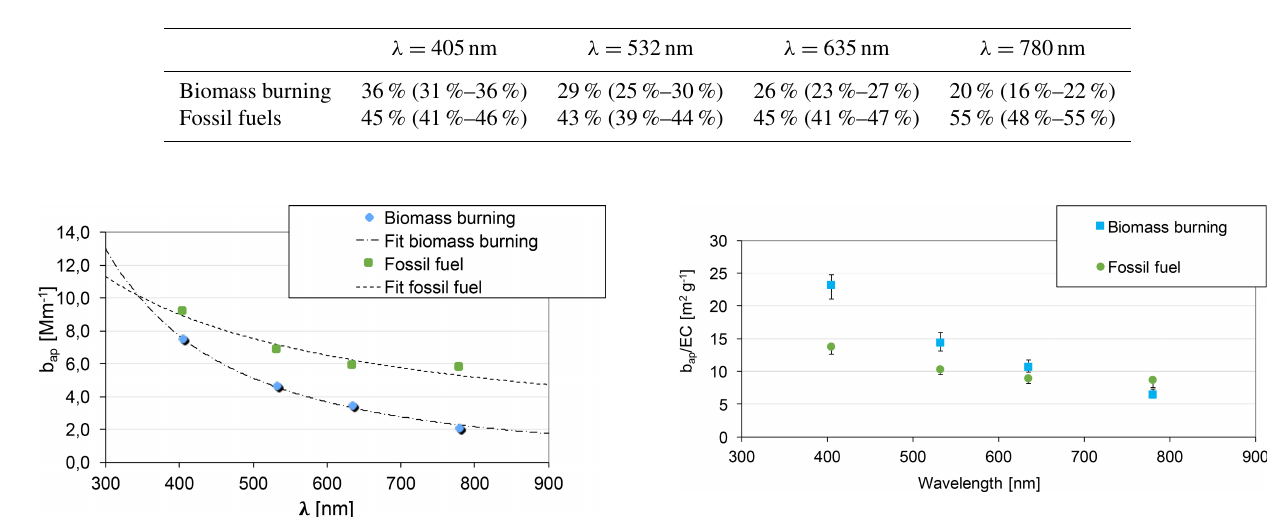
Table 2. Average contribution to total reconstructed b ap for the biomass burning and fossil fuel factors; in parentheses the 25th and 75th percentiles are reported.